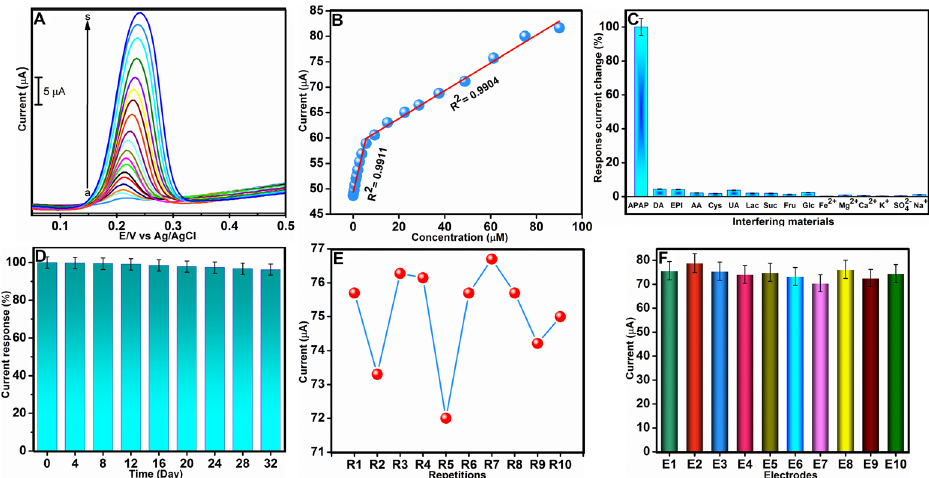
Figure 7. ( A ) DPV curves at AgCuO NPs/fCNTs/SPCE under different APAP concentrations (a–s). ( B ) Peak currents vs. APAP concentrations. ( C ) Selectivity. ( D ) Stability. ( E ) Repeatability. ( F ) Re- producibility. Table 1. Comparative evaluation of AgCuO NPs/fCNTs-based electrode with other modified elec- trodes toward APAP detection.